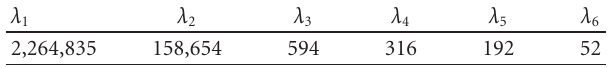
Table 2: First six eigenvalues of the covariance